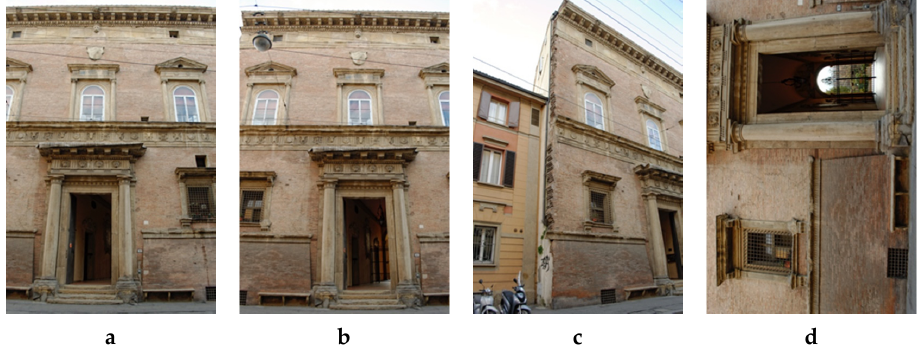
Figure 10. The images used to assess the pairwise matching efficiency of the tie point extraction procedure: parallel acquisitions with short baseline ( a , b ); tilt of ca. 45° ( c ) and rotation of ca. 90° ( d ).